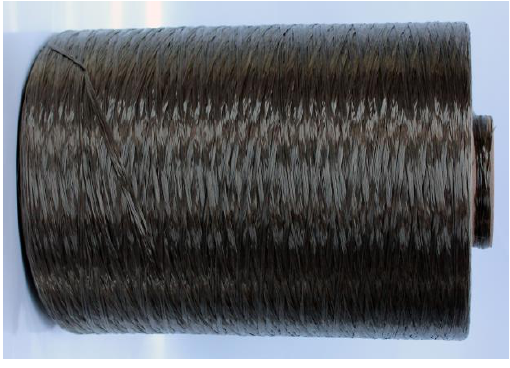
Figure 1. Continuous untwisted basalt fibers. Table 1. Quantitative XRF results of desized basalt fibers.